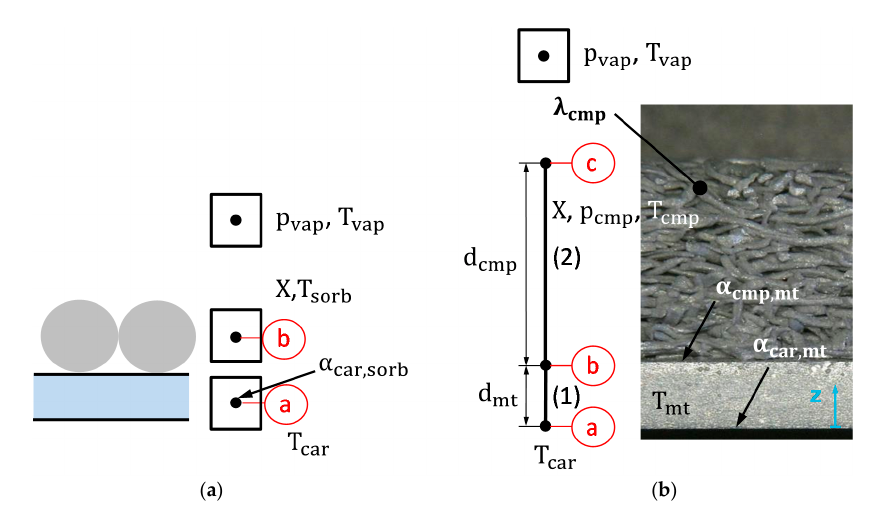
Figure 2. Schematic drawing of models for granules ( a ) and for directly crystallized SAPO-34 on a fibrous structure ( b ). In both models, the vapor volume is not spatially resolved (zero dimensional).